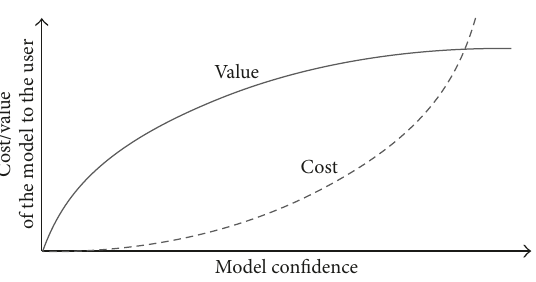
Figure 12: Model